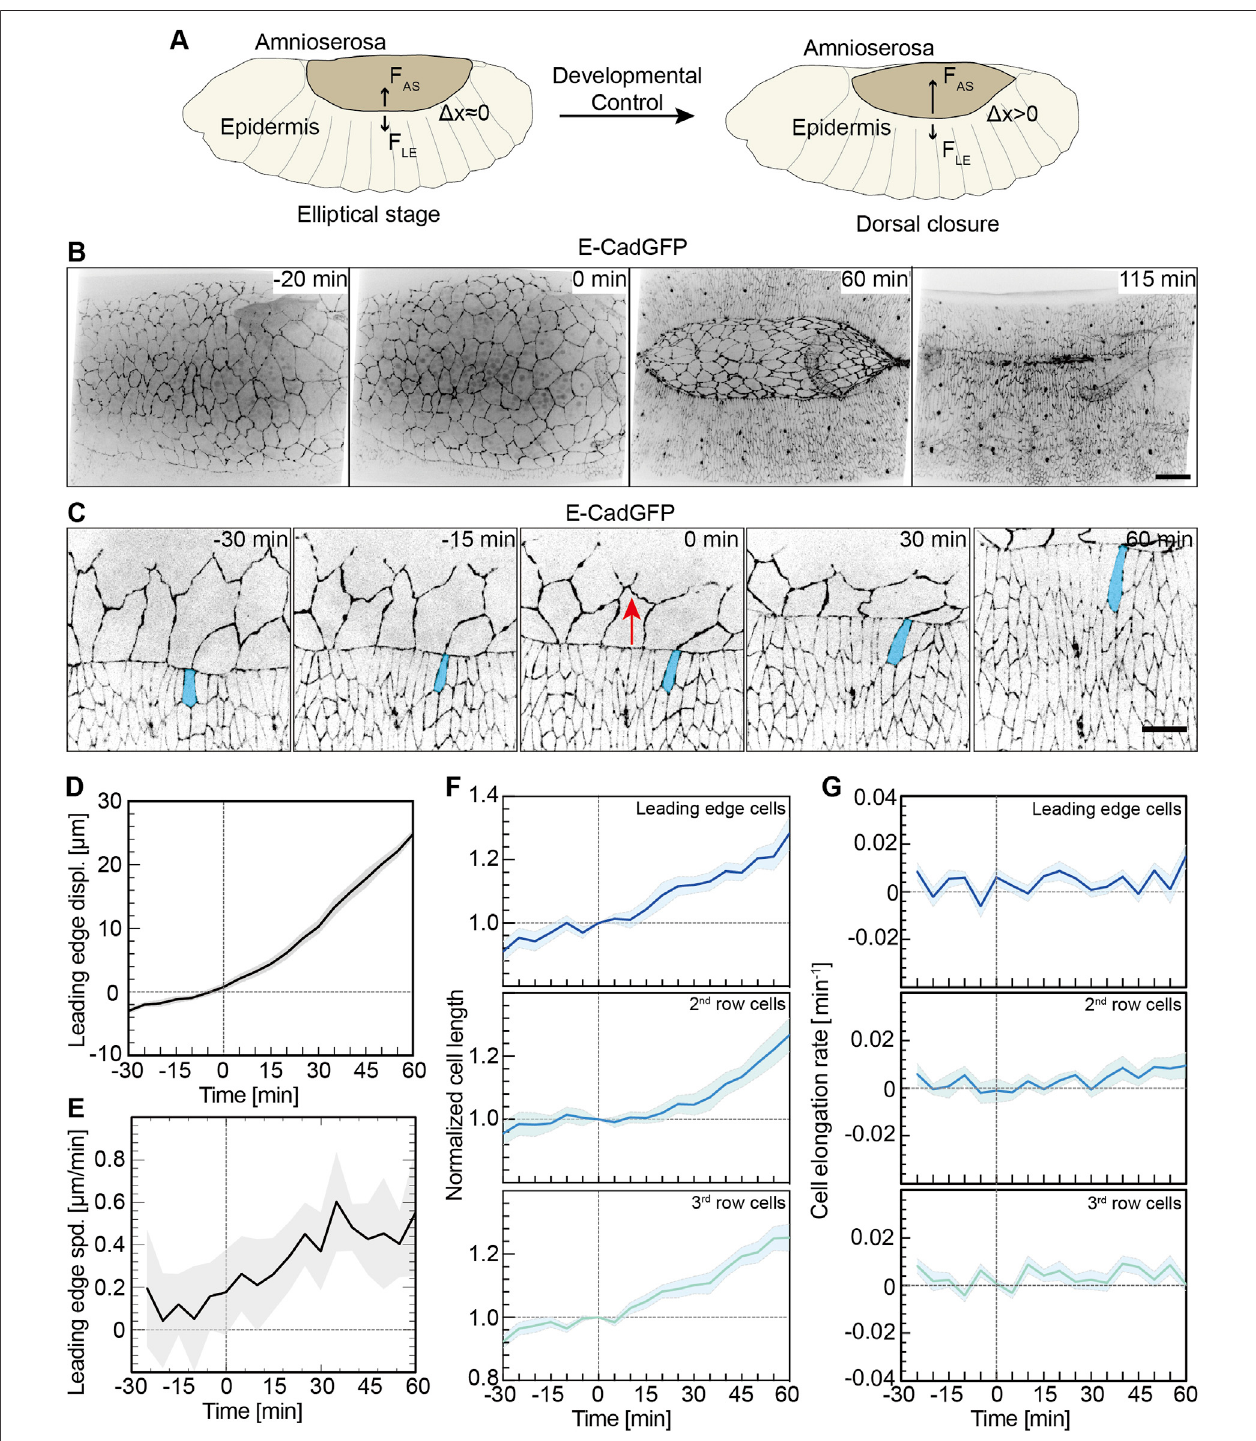
FIGURE 1 | Lateral epidermal cells elongate in a pulsatile manner. (A) Schematic representation of a Drosophila embryo in the ellipsoidal stage and undergoing dorsal closure. F AS , the AS contractile forces; F LE , forces from the lateral epidermis; and △ x, the lateral epidermis movements dorsally. (B) Images from a time-lapse recording in an embryo expressing E-CadGFP undergoing dorsal closure (0 min, onset of dorsal closure with the noticeable displacement of leading-edge dorsally). Scale bar is 25 μ m. (C) Images from a time-lapse recording of an embryo expressing E-CadGFP show that the surrounding epidermal cells elongate along the dorsal – ventral axis during dorsal closure; 0 min, onset of dorsal closure with the noticeable displacement of the leading edge dorsally. A leading-edge epidermal cell is highlighted in blue. The red arrows indicate the movements of the leading edge during dorsal closure. Scale bar is 10 μ m. (D,E) Quanti fi cation of the leading-edge